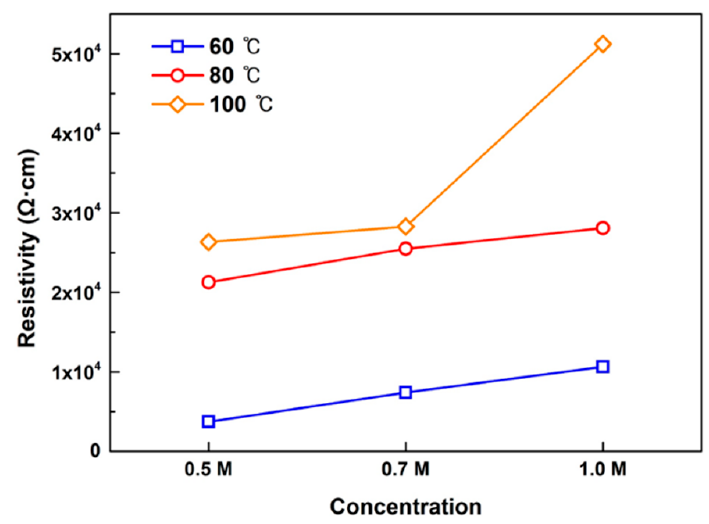
Figure 7. Electrical resistivities of all samples.